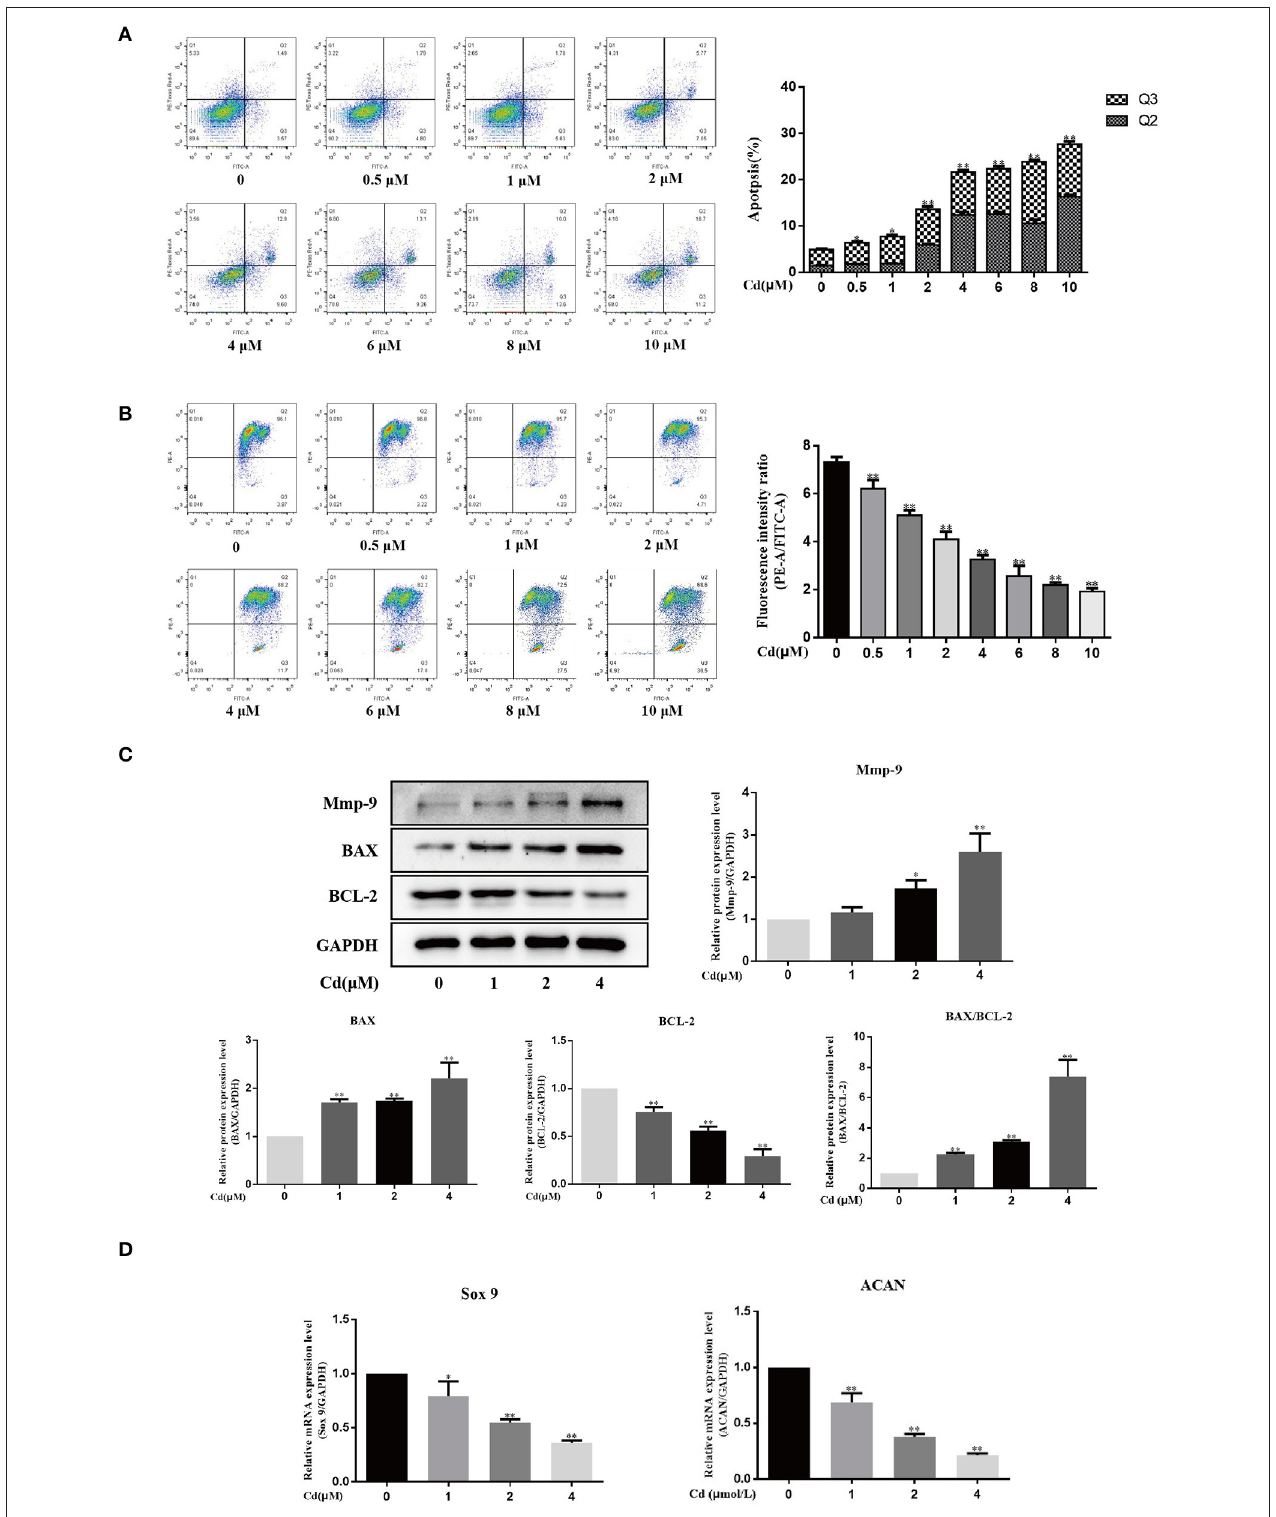
FIGURE 3 | Cd inhibited chondrocyte differentiation and induced apoptosis and MMP-9 expression in chondrocytes. (A) Apoptosis rate of chondrocytes treated with different concentrations of Cd for 24h. For flow cytometry, the Q1 quadrant represents the mechanical damage in chondrocytes, the Q2 quadrant represents late apoptosis in chondrocytes, the Q3 quadrant represents early apoptosis in chondrocytes, and the Q4 quadrant represents the normal chondrocytes. Compared with